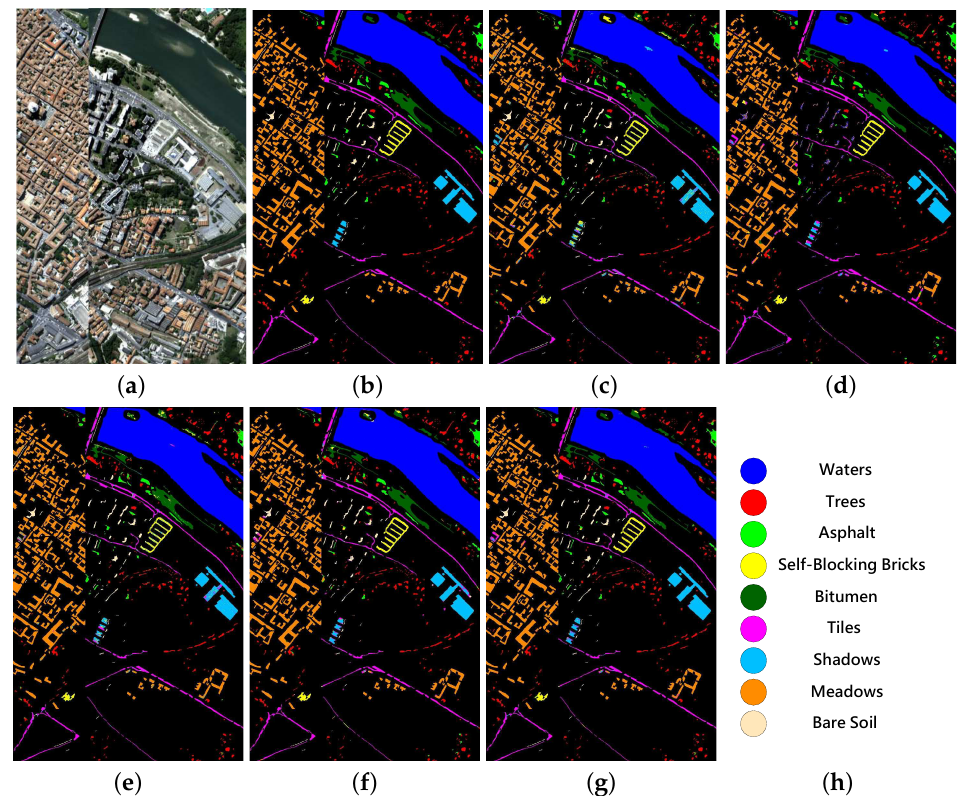
Figure 7. Classification maps using different methods on the Pavia Center dataset: ( a ) False-color image, ( b ) Ground-truth map, ( c ) RNN, ( d ) CNN, ( e ) RNN with attention (ARNN), ( f ) CNN with attention (ACNN), ( g ) spectral-spatial attention network (SSAN). Table 7. Classification performance of different methods for the Pavia Center dataset. Bold indicates the best